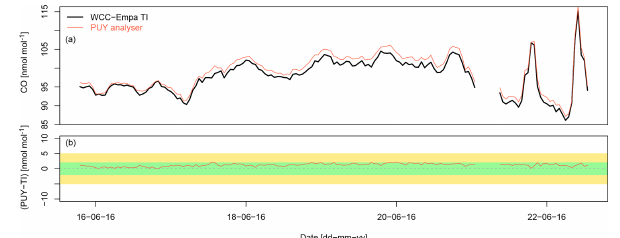
Figure 11. Comparison of hourly averages of CO at PUY between the WCC-Empa travelling instrument and the PUY Picarro G2401 for the period when the TI sampled dry air. (a) CO time series. (b) CO bias of the station analyser vs. time. The green and yellow areas correspond to the WMO network compatibility and extended network compatibility goals.